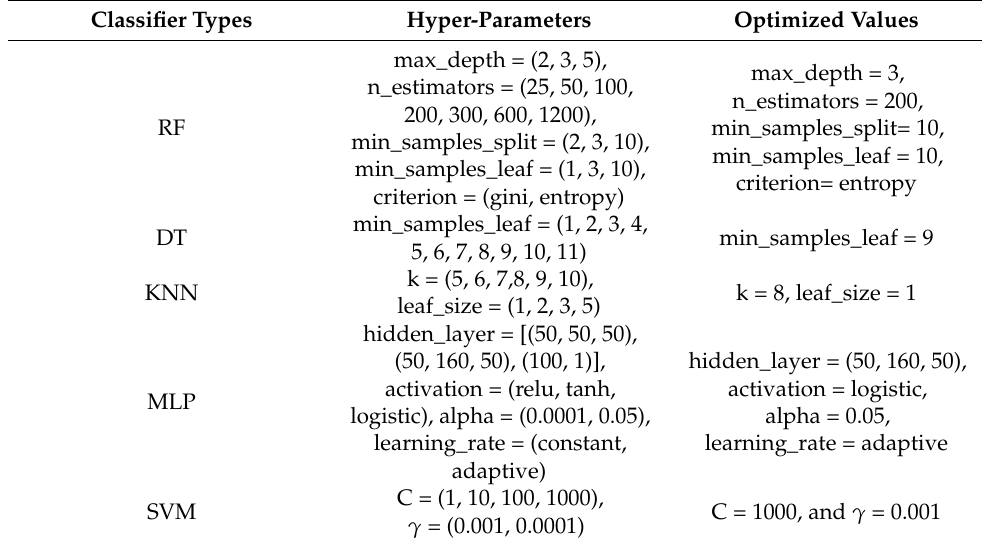
Table 2. Optimized hyperparameters of different classifiers using the grid search